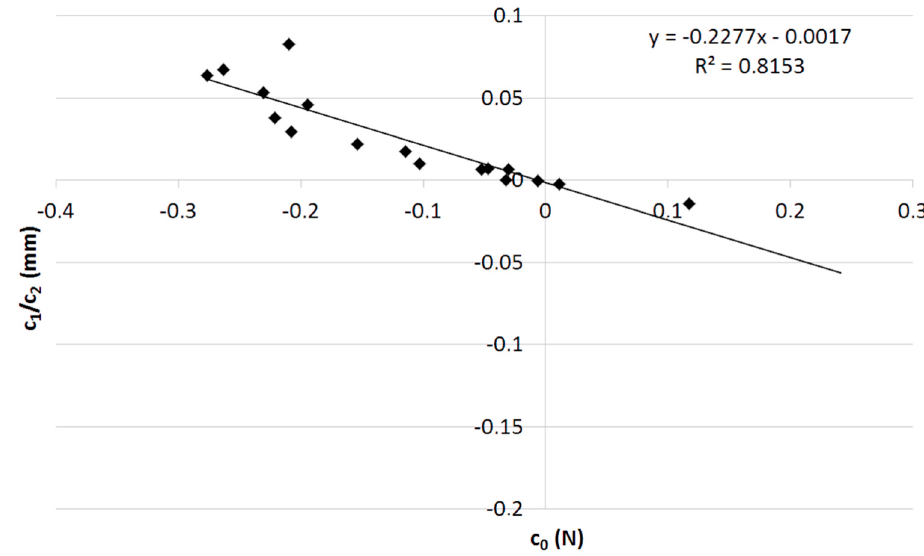
Figure 4. Relation between c 0 and c 1 /c 2 .